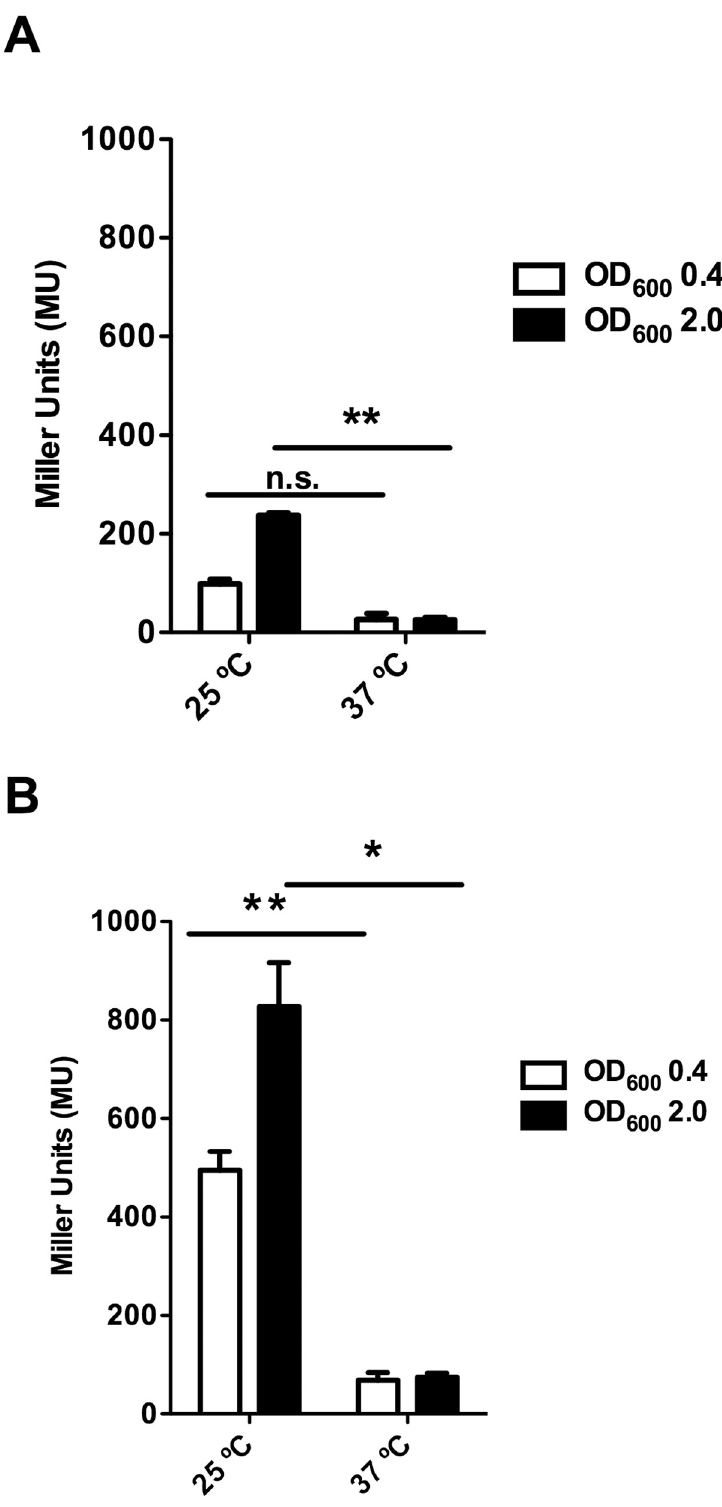
Fig 4. Temperature- and growth medium-dependent expression of the rsp gene. Effect of the growth medium and growth temperature on transcription of the rsp gene determined by using a rsp :: lacZ transcriptional fusion. Samples were collected from cultures grown in LB (A) or M9 media (B) at 25 and 37˚C., either at the exponential (O.D. 600